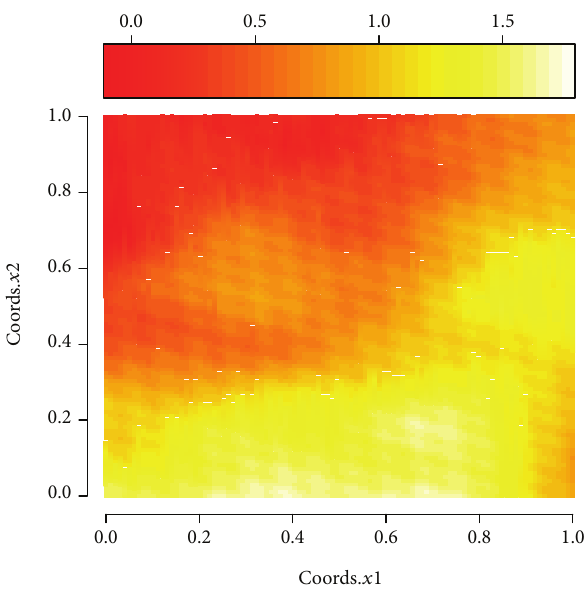
Figure 1: Simulation of regular spaced lattice